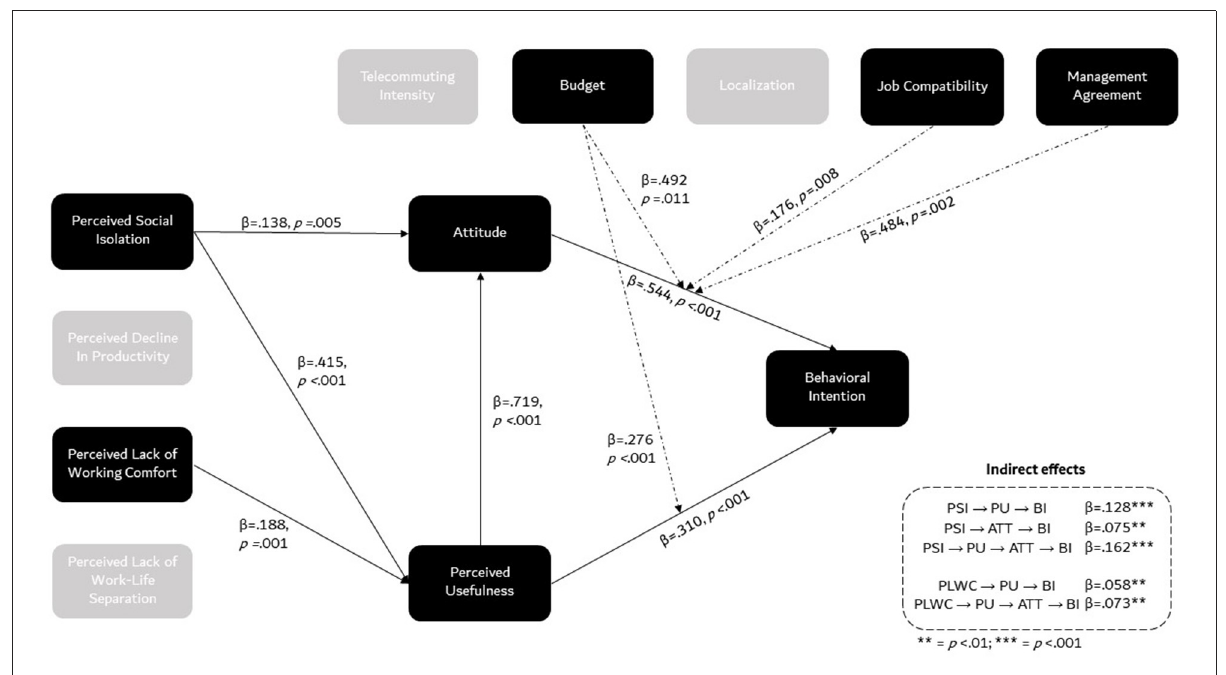
FIGURE2 Overview of the results of the moderated mediation